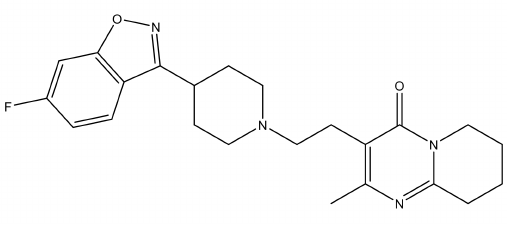
Figure 1. Chemical structure of